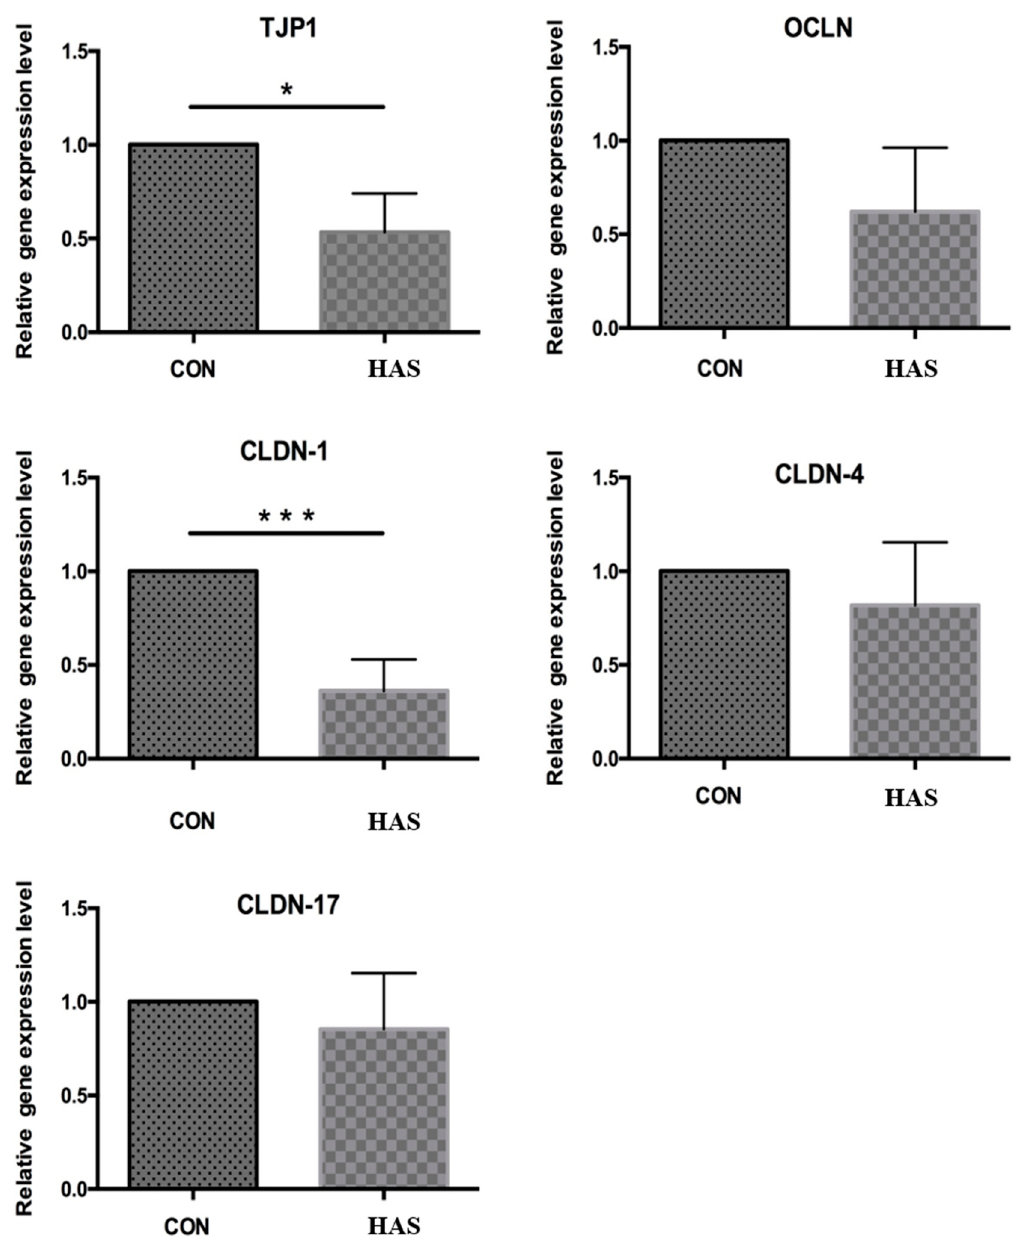
Figure 11. Effect of high sulfur diet on the relative expression of tight junction genes in the rumen epithelium. CON-S (%DM) 0.4%; HAS-S (%DM). TJP1 = tight junction protein 1; OCLN = Occludin; CLDN-1 = Claudin-1; CLDN-4 = Claudin-4; CLDN-17 = Claudin-17. Asterisks mean significant difference between treatments.